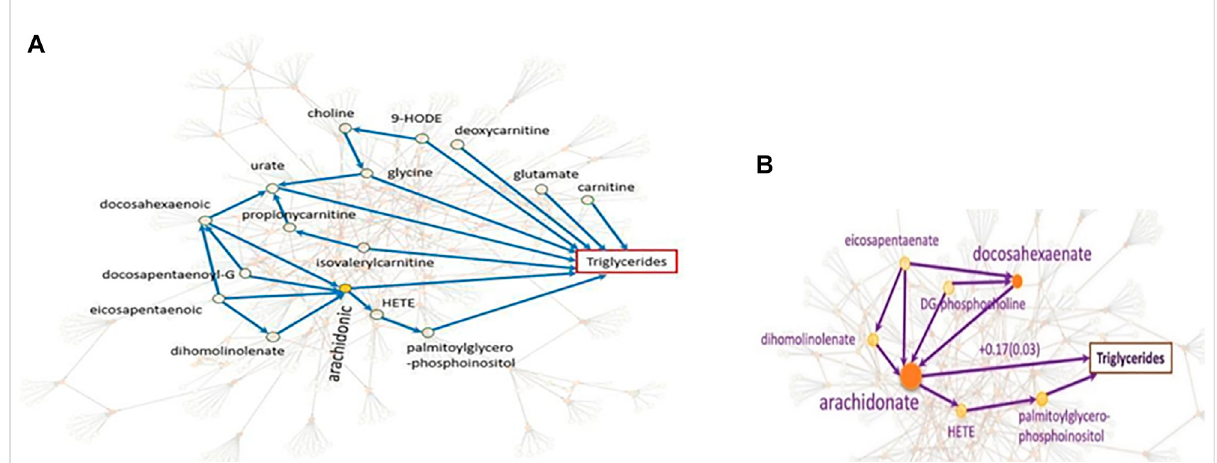
FIGURE 7 Systematic integration ofgenetics,metabolomics,andtriglycerides. (A). Thefocusisonthenine metabolites withdirecteffectsontriglycerides as well as some of the indirect effects. For example, no need to know about the levels of choline if we know about glycine levels since the effect of choline on triglycerides is only through glycine. (B). We see that the effect of four metabolites on triglycerides is through arachidonate with the largest effect on triglycerides (Yazdani et al.,